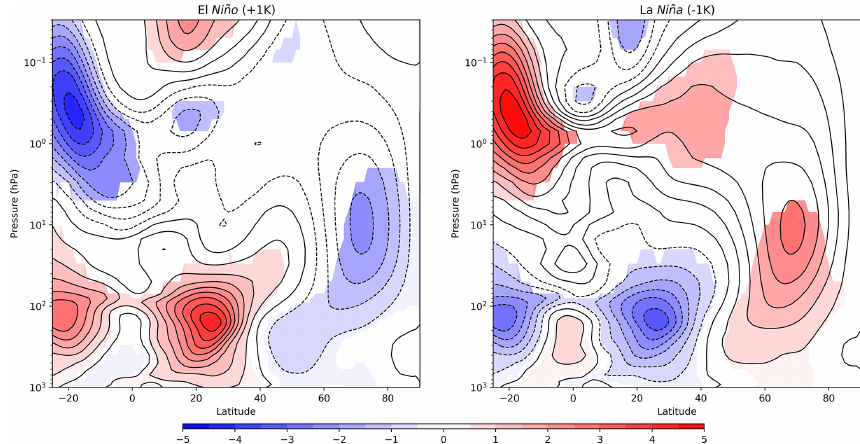
Figure A2. December–March ZMZW anomaly composites for positive (El Niño) and negative (La Niña) phases of the Niño 3.4 index evaluated in September–November. The phase of Niño 3.4 is defined as an SST anomaly of greater magnitude than 1K. Coloured shading indicates anomalies significant above the 95% confidence level under a two-tailed Student’s t